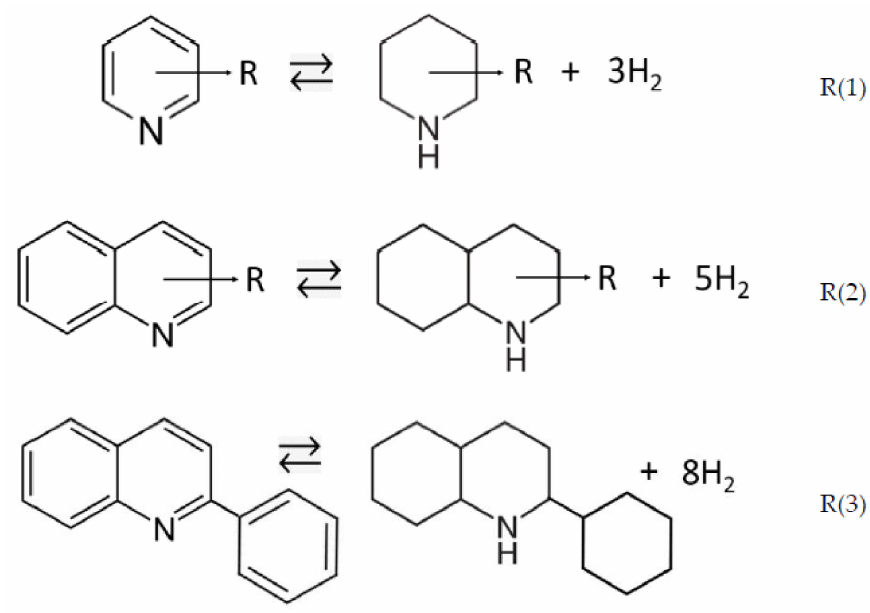
Figure 1. Hydrogenation/dehydrogenation reactions of substituted pyridines or